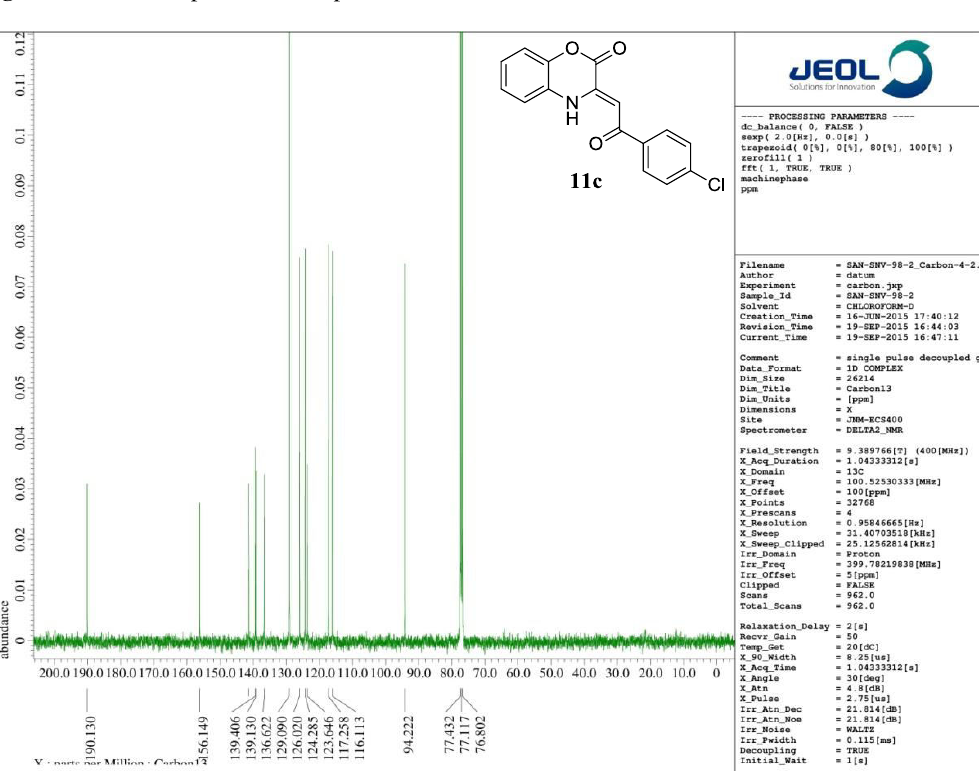
Figure 5. 1 H NMR Spectra of Compound 11c .